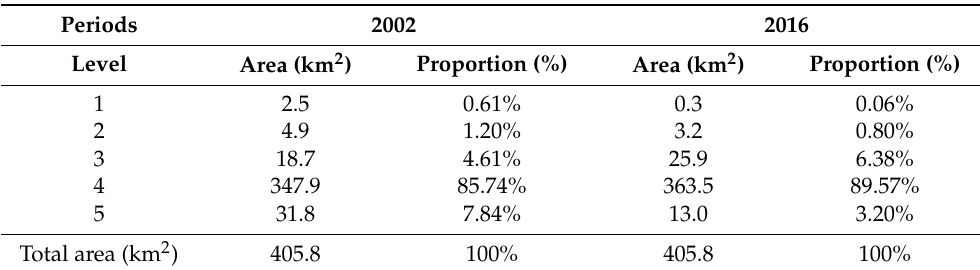
Table 2. The area proportion of different vegetation coverage levels in the contrast test area in 2002 and